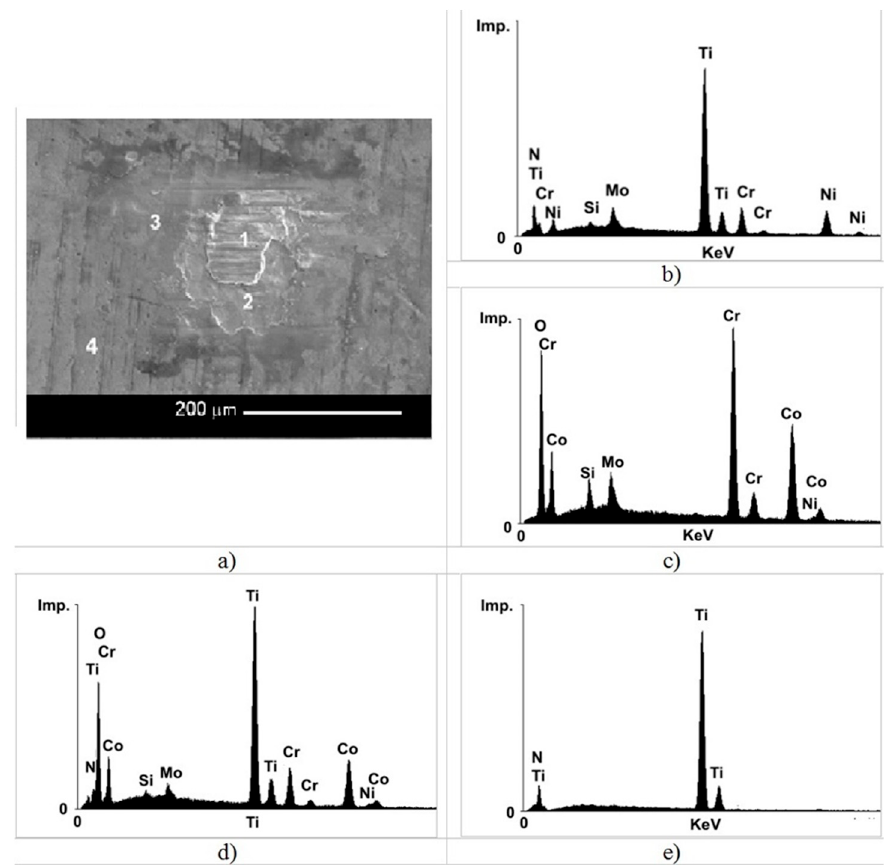
Figure 6. Area of friction tracks obtained with the load of 15 MPa and for the time of 120 min for sample S1. ( a ) Microscopic image with marked areas of EDS analyses; ( b ) EDS analysis in point 2; ( c ) EDS analysis in point 1.